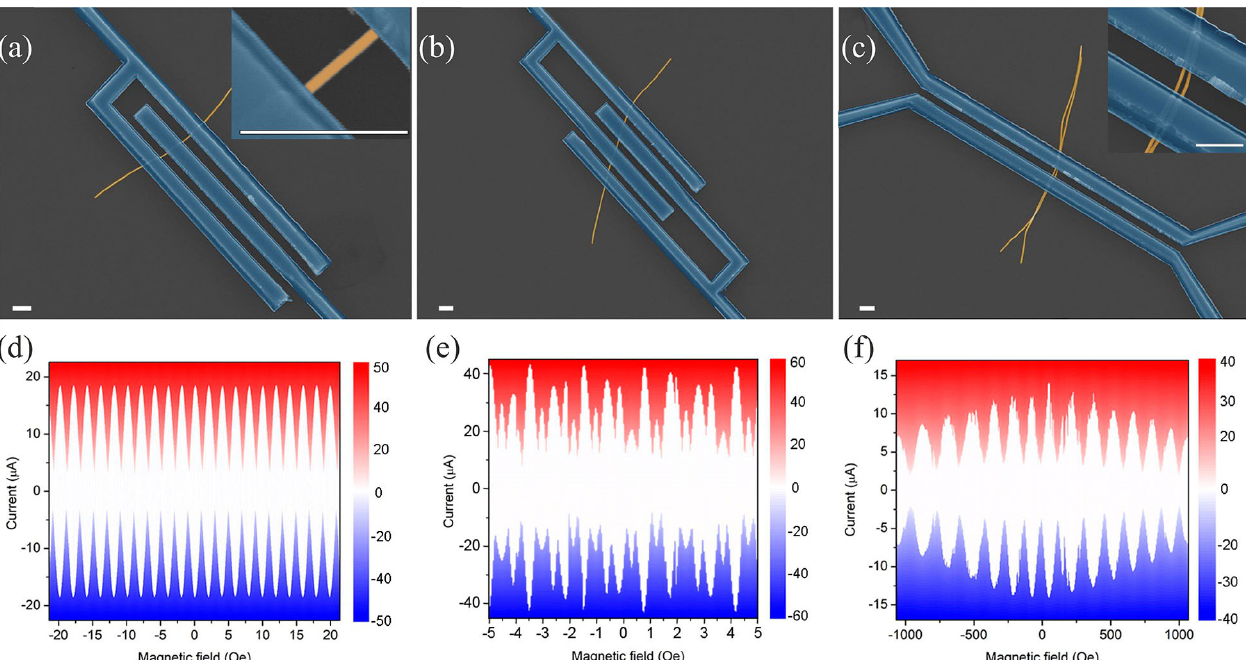
Figure 2. Scanning electron microscope images of ( a ) sample A (insert—Zoom of the Josephson junction), ( b ) sample B , and ( c ) sample C with zoom of the central part of the sample C . The scale bar is 1 µ m. The corresponding sets of current-voltage characteristics in various magnetic fields for these samples are shown in panels ( d – f ); voltage scale is in µ V (displayed in